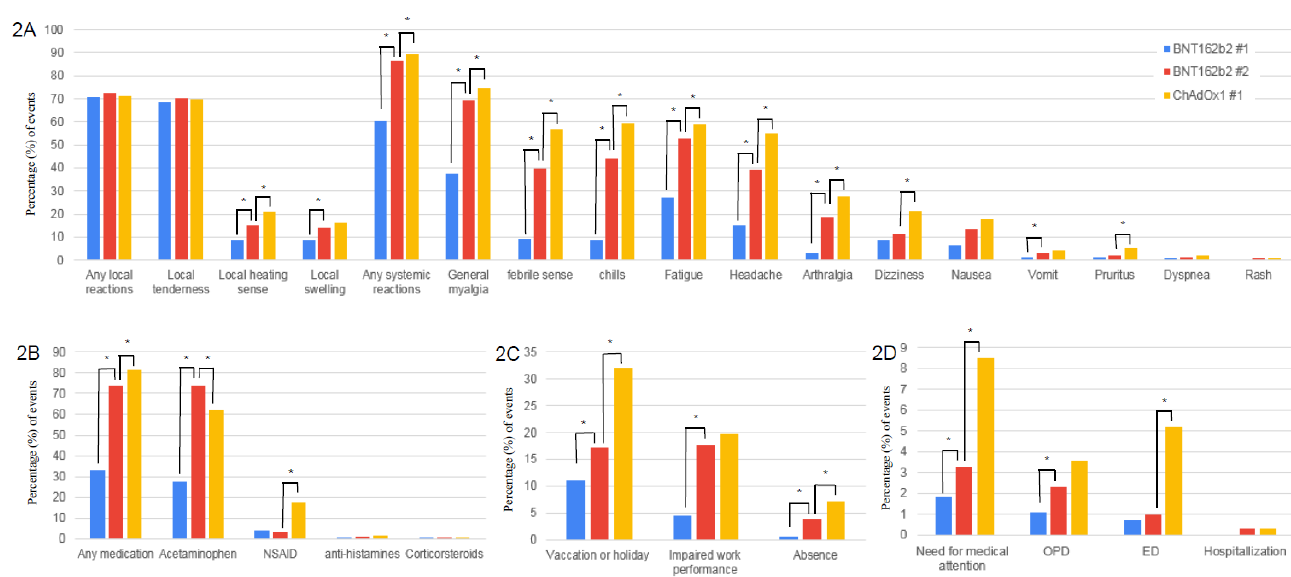
Figure 2. Side effectsand their impacts on post-vaccination medication, work, and medical use after anti-SARS-CoV-2 vaccination according to vaccine dose and type. ( A ) shows side effects. ( B ) shows post-vaccination medication. ( C ) shows impact on work. ( D ) shows medical use after vaccination. ChAdOx1 #1, the first dose of ChAdOx1; BNT162b2 #1, the first dose of BNT162b2; BNT162b2 #2, the second dose of BNT162b2; NSAID, nonsteroid anti-inflammtory drug; ED, Emergency department; OPD, out-patient department. * p -value < 0.05 when comparing frequencies of events according to vaccine type and dose.